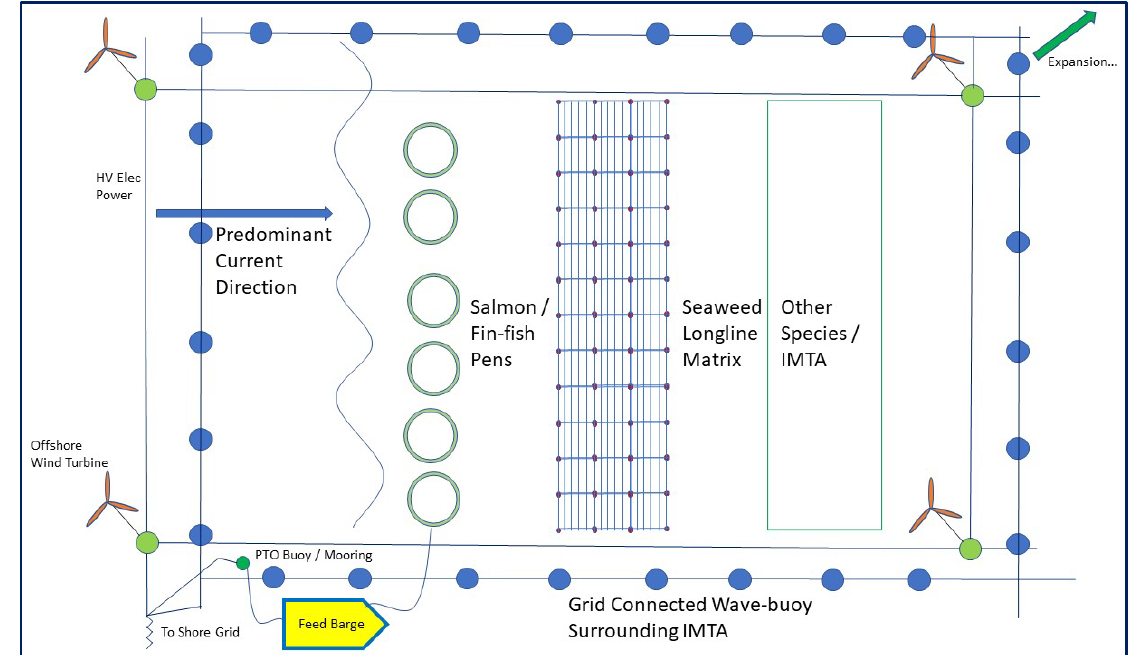
Figure 30. IMTA system surrounded by wave suppressing grid connected wave buoy annulus.